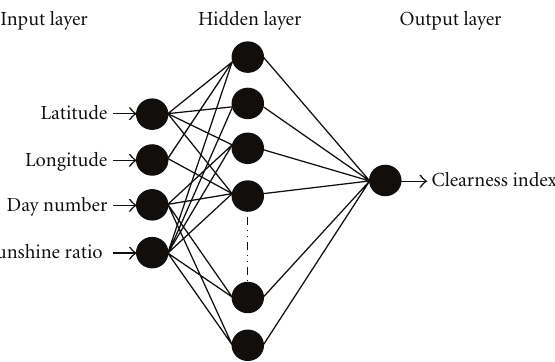
Figure 4: Topology of the FFMLP ANN used to predict the clearness